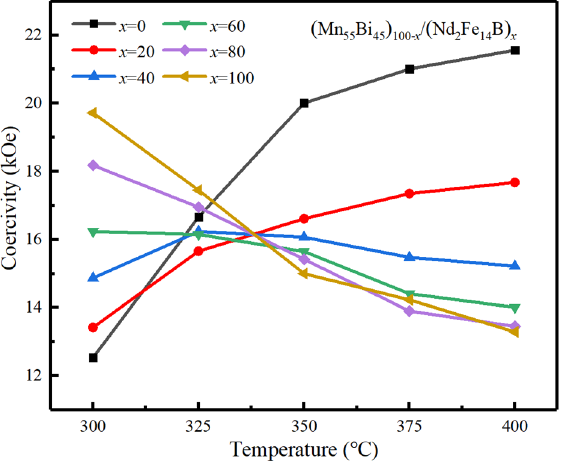
Figure 5. The temperature dependence of coercivity of the bulk (Mn 55 Bi 45 ) 100 − x /(Nd 2 Fe 14 B) x ( x = 0, 20, 40, 60, 80, and 100) hybrid magnetic alloys.